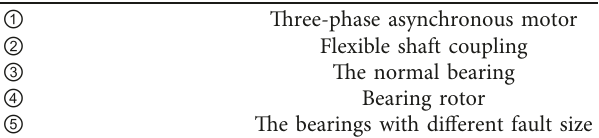
Figure 6: The experimental bench system. Table 1: The test bench components.